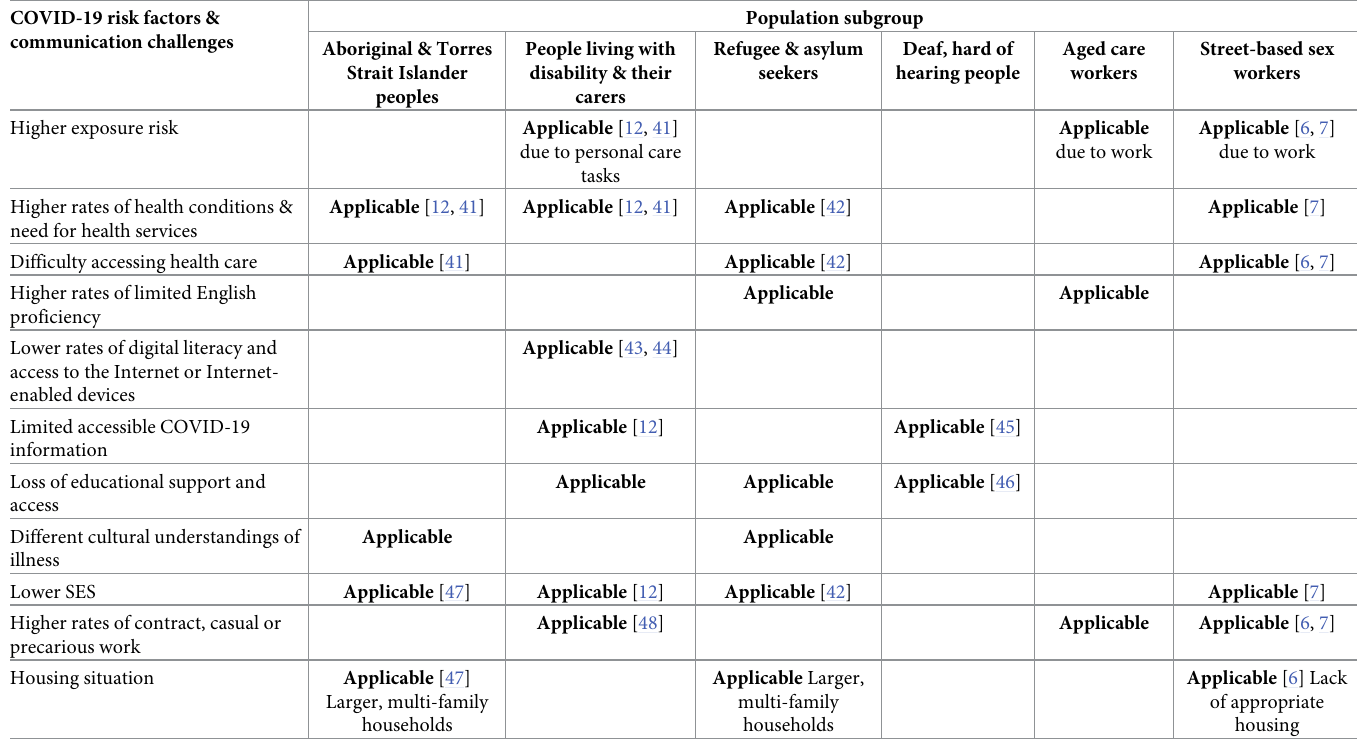
Table 1. Project population subgroups and their associated COVID-19 risk factors & communication